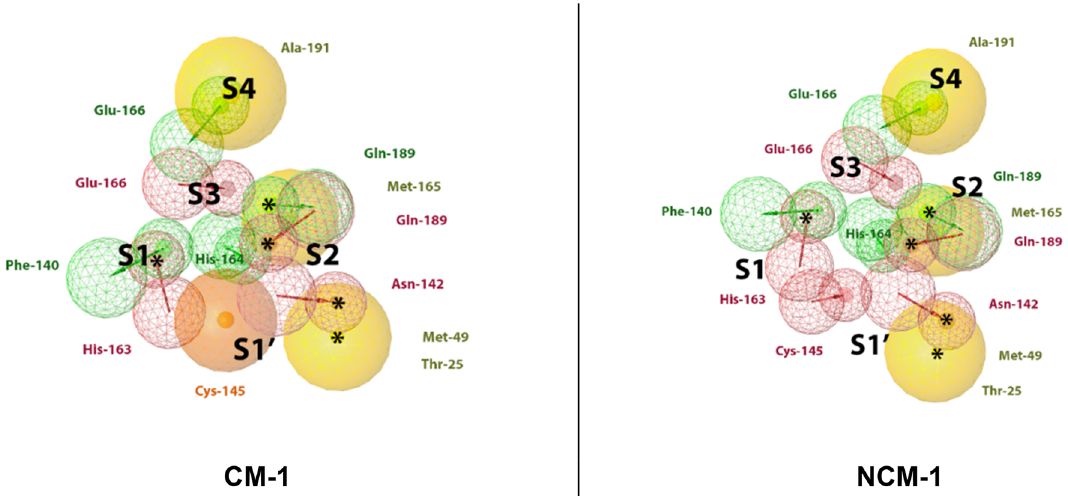
Figure 6. Best covalent CM-1 and non-covalent NCM-1 models according to ROC-AUC and BACC values. HBD (green), HBA (red), hydrophobic (yellow), residue bonding point (orange), and optional feature (*). The residues reported in the models were identified by LigandScout.